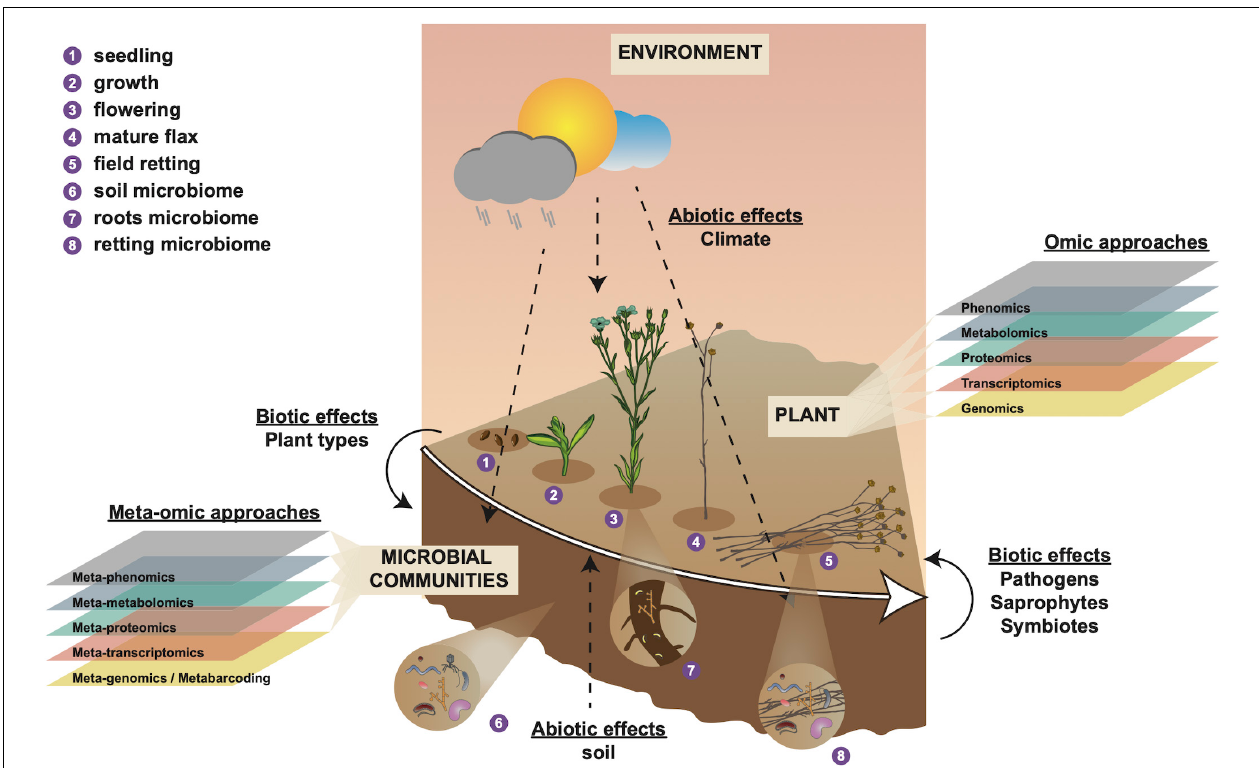
FIGURE 1 | Holistic overview of intrinsic and extrinsic factors contributing to flax fiber phenotype and different scales of (meta-)omic investigation. Numbers 1–4 represent different stages in the development of the flax plant and number 5 represents the retting stage. Number 6 represents the soil microbial community that will interact with plant roots during plant growth (number 7) and with the plant stem during retting (number 8). Biotic effects ( left side) represent how plant organic material (e.g., leaves) affect soil microbiota. Biotic effects ( right side) represent how microbiota affect the flax plant during retting (progressive degradation of cell walls). Abiotic effects (soil) represent how soil parameters (e.g., soil type, pH, mineral disponibility, water content) affect the plant during growth. Abiotic effects (climate) represent how meteorological conditions affect plant growth, soil parameters, and microbiome during plant growth (numbers 1–4) and retting (number 5). Omic approaches indicate different scales of investigation that can be used to investigate intrinsic (plant) biology during growth (numbers 1–4). Meta-omic approaches indicate different scales of investigation that can be used to characterize the microbial community during plant growth and retting (numbers 1–5). This diagram underlines the importance of considering the plant-microbiome-environment as a ‘holobiont’ for a complete understanding of how numerous different factors contribute to shaping fiber